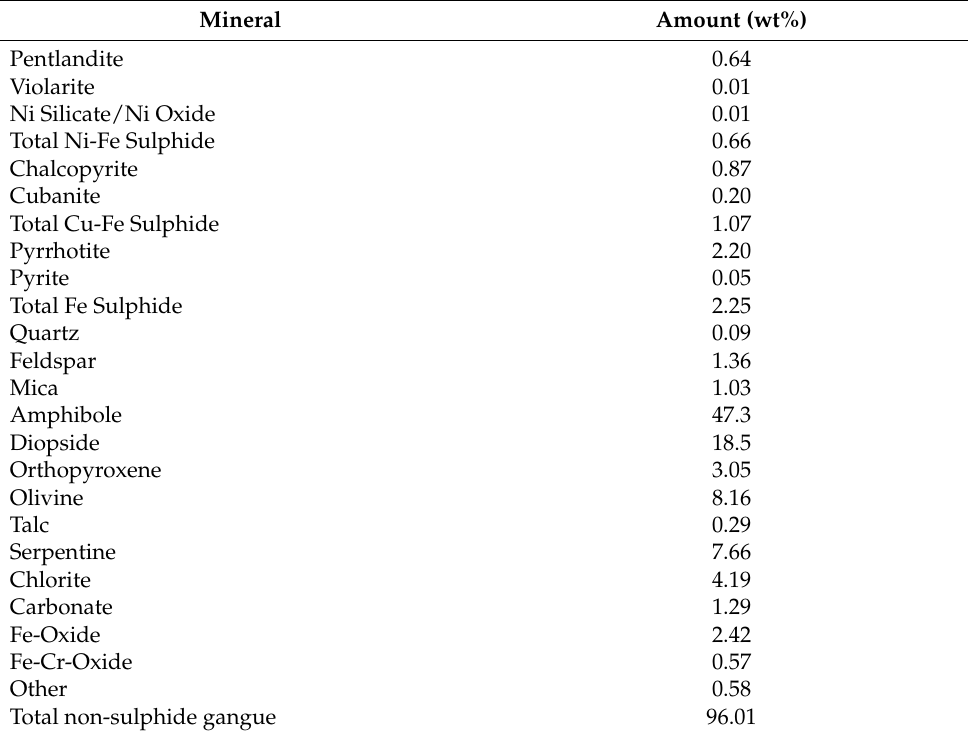
Table 1. Average mineral composition of the Kevitsa